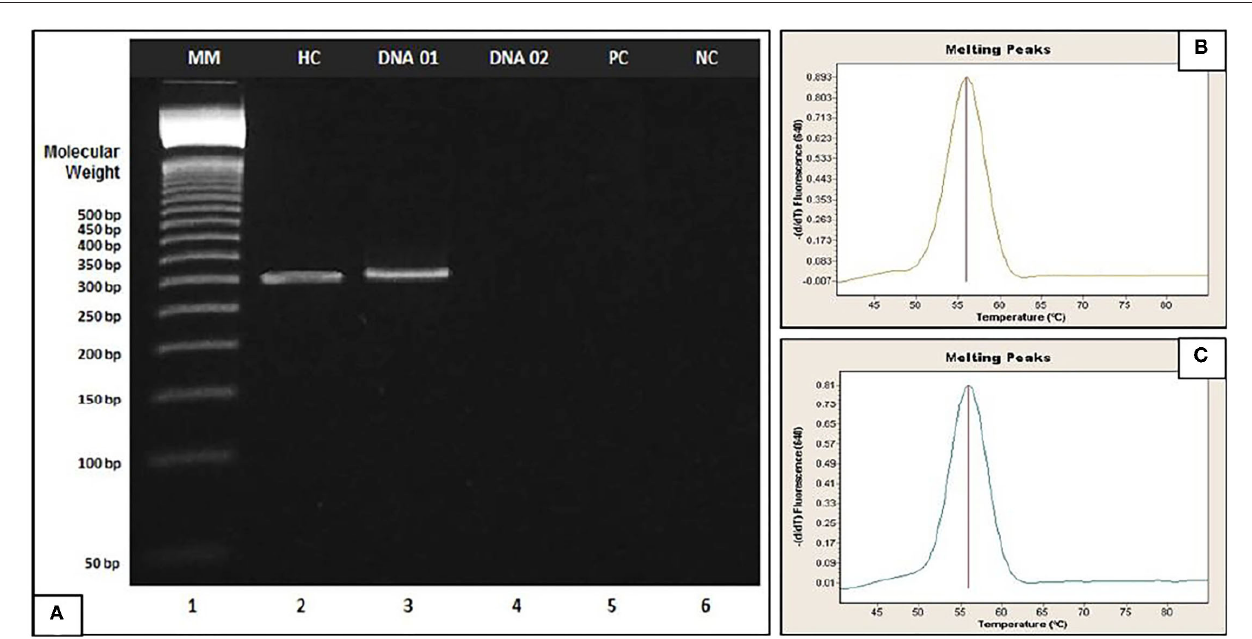
FIGURE 2 | (A) Agarose gel electrophoresis of fragile X. Example applied to patients (DNA 01 and DNA 02). Lane 1 (MM): 50-bp DNA Step Ladder, Lane 2: Healthy Control (HC), Lane 3 (DNA 01): Healthy patient, Lane 4 (DNA 02): Affected patient, Lane 5: Positive Control (PC) and Lane 6: Negative Control (CN). (B,C) Amplification of genetic material by Real-Time PCR of DNA 02 and Positive Control respectively; DNA 02 and Positive control were quantified in Quantus Fluorometer (Promega, Wisconsin, USA) and concentration values between 65 and 75 ng/ µ l were